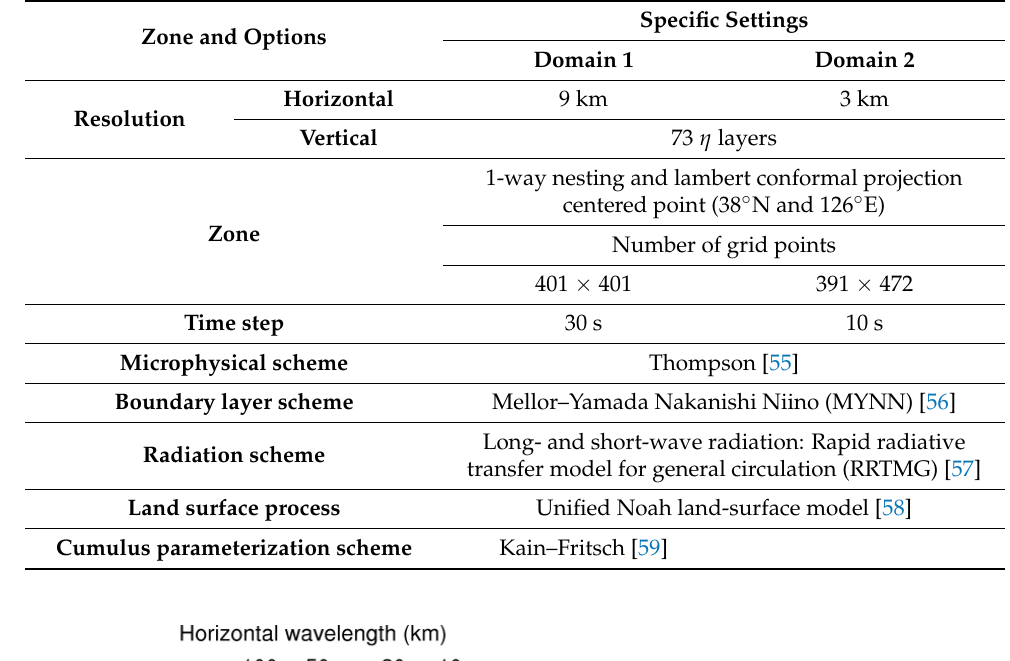
Table 1. Model configuration for weather research and forecasting (WRF) simulation.